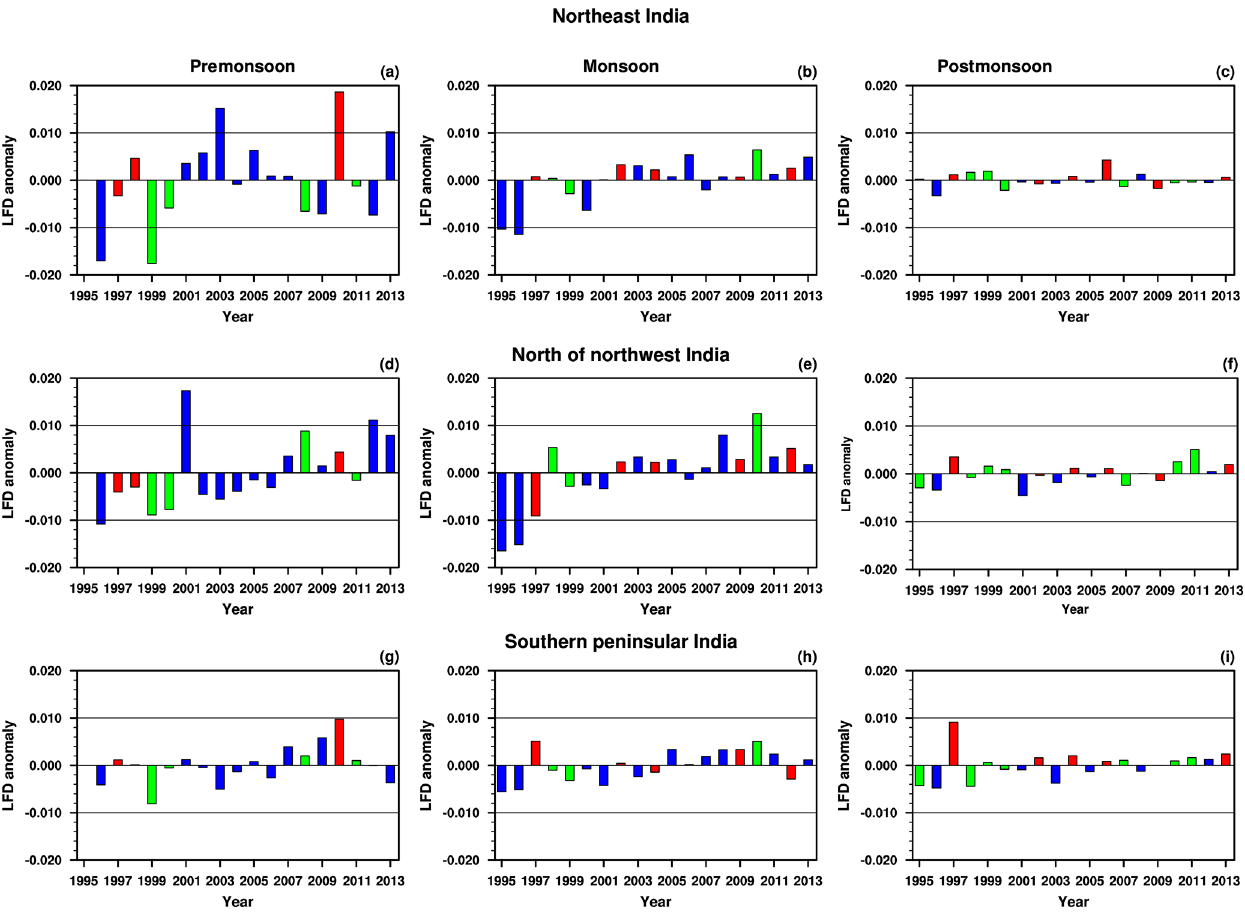
Figure 4. Anomalous LFD during the individual years with different ENSO phases. The red bar corresponds to warm phases of ENSO, the green bar corresponds to cold phases of ENSO and the blue bar indicates the neutral phases of